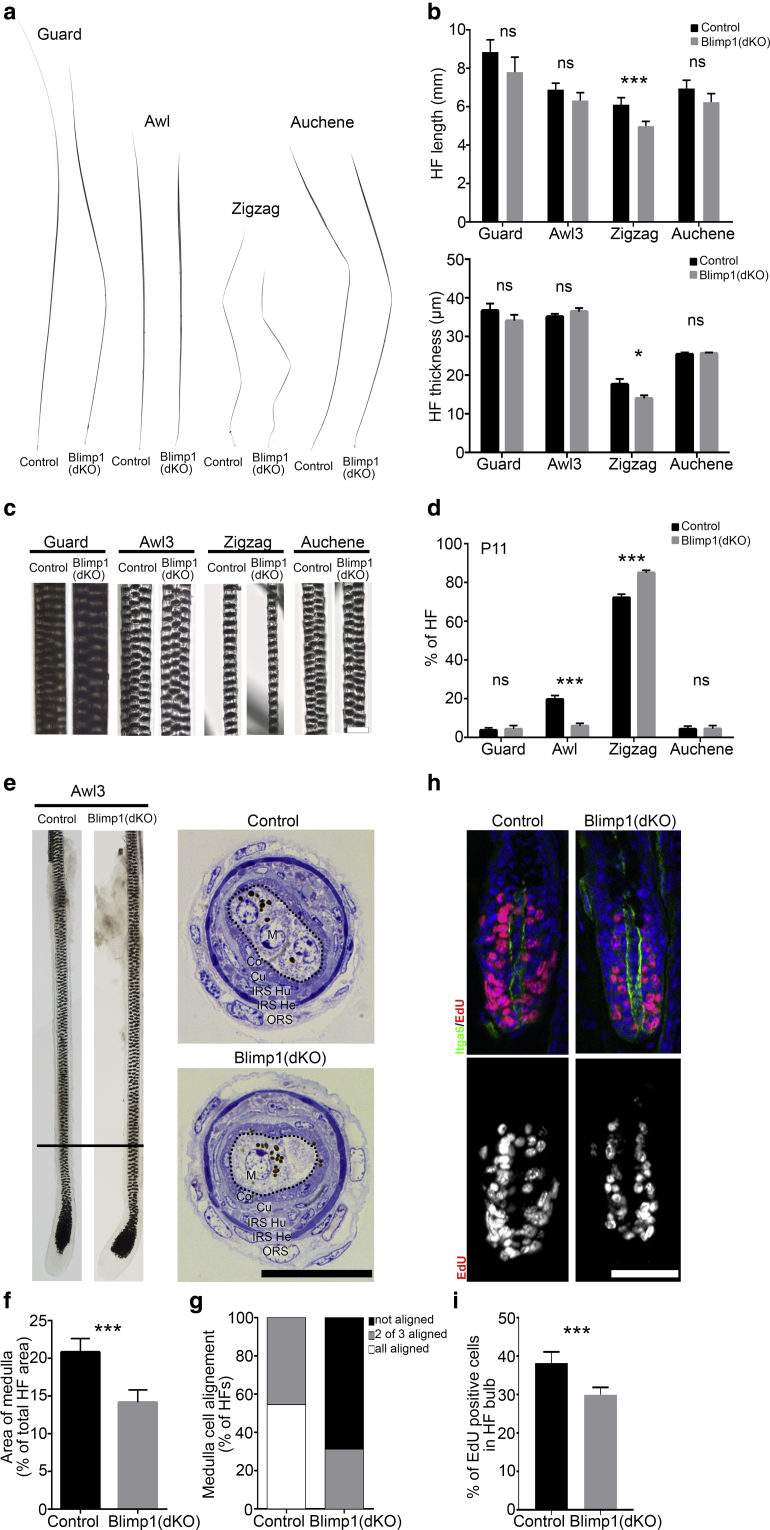
Dermal Blimp1 ablation impairs the HF maturation process leading to changes in HF size, thickness, type, and medulla cell organization. (a) Bright field images of HF types at P60 and (b) quantification of HF length (upper panel) and thickness (lower panel). (c) HF type bright field close-up at P60. (d) HF type quantification at P11. (e) Bright field image of microdissected awl3 HF (left panel) and HF transversal semithin section. The black bar indicates the region of the HF cross section shown in the right panel. (f, g) Quantification of medulla cell (f) area and (g) alignment in awl3 HF cross sections. (h) EdU labeling of P11 back skin sections immunostained for Itga6 and (i) quantification. Data shown are means ± standard deviation. ∗P < 0.05, ∗∗∗P < 0.0005. Scale bars = 20 μm (c), 25 μm (e), 50 μm (h). Blimp1, B-lymphocyte-induced maturation protein 1; Co, cortex; Cu, cuticle; EdU, 5-ethynyl-2’-deoxyuridine; He, Henle layer; HF, hair follicle; Hu, Huxley layer; IRS, inner root sheet; M, medulla; ns, not significant; ORS, outer root sheath.